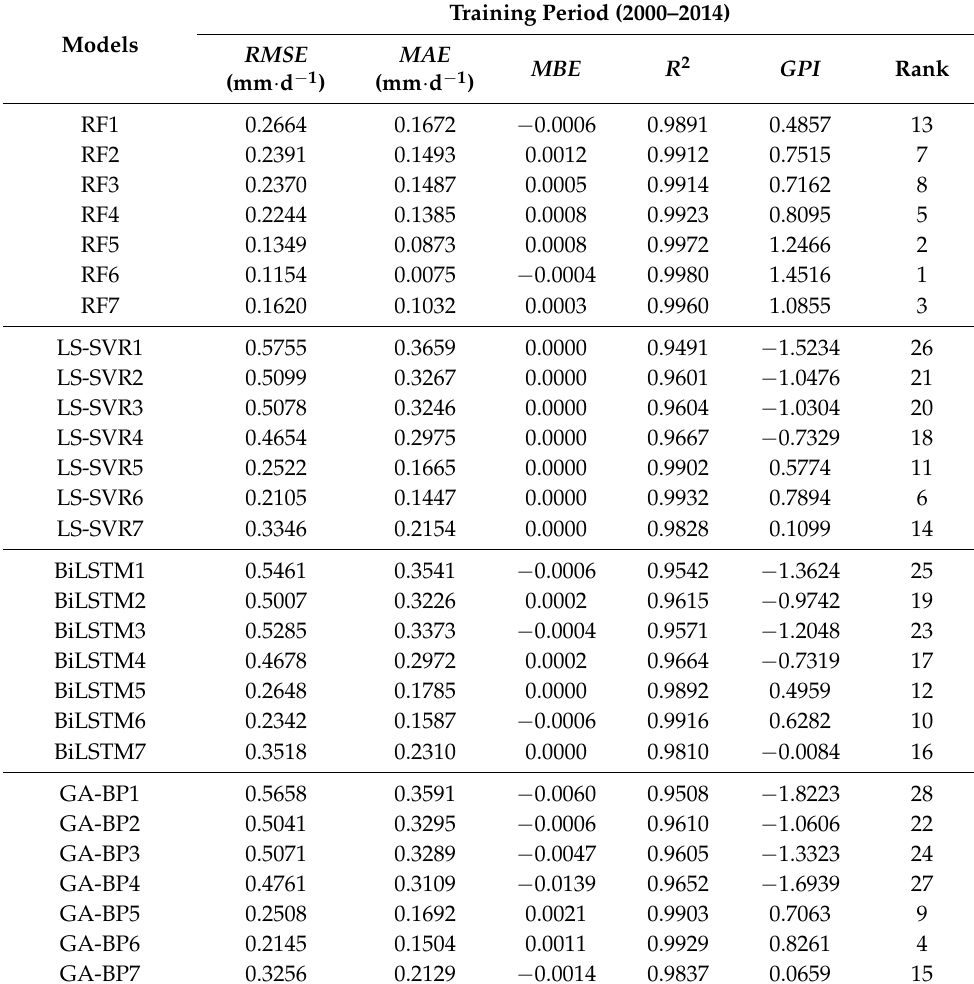
Table 4. Performance of RF, LS-SV, Bi-LSTM and GA-BP models during the training